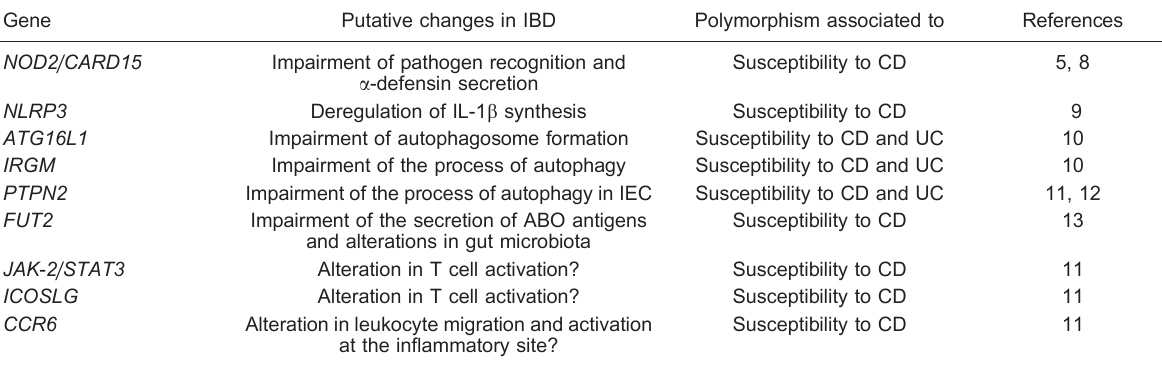
Table 1. Examples of polymorphisms associated with inflammatory bowel diseases (IBD).